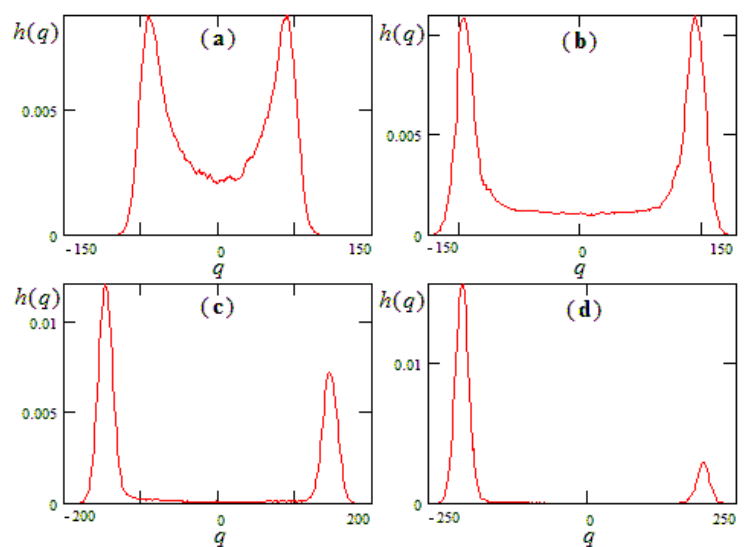
Figure 12: The distribution of the order parameter h ( q ) for the Gillespie stochastic simulation as a function of the number of RNAp molecules in the multimer case: (a) N = 50 ; (b) N = 100 ; (c) N = 150 ; (d) N = 200